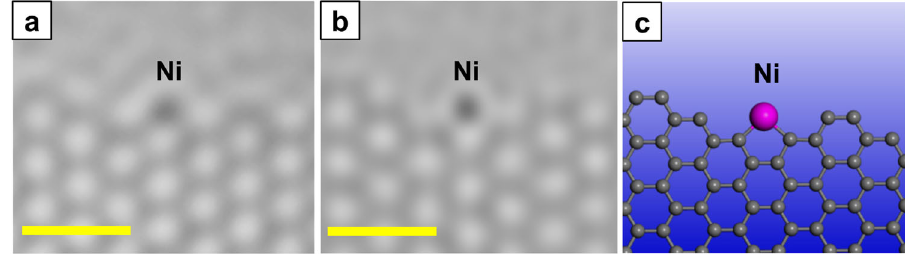
Fig. 11 Ni atoms at a graphene armchair site. a TEM micrograph showing a Ni atom at a graphene armchair site. b Image simulation of the image in panel a and ( c ) Stick and ball model used to form the image simulation in panel b . All scale bars are 5 Å.